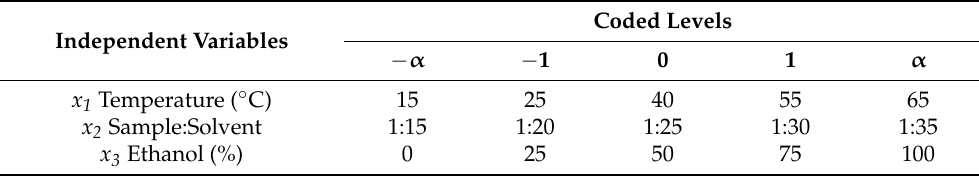
Table 1. Factors and levels used for central composite design analysis for glucosinolate extraction. Independent Variables